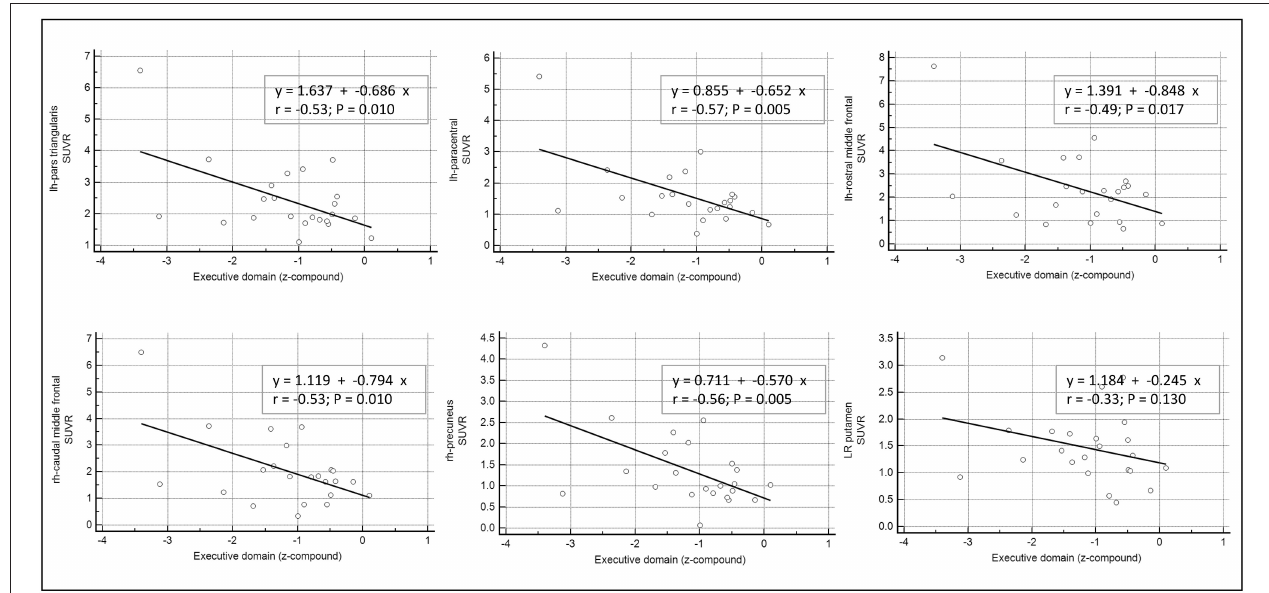
FIGURE 2 | Correlation between β -amyloid load in cortical and subcortical areas and cognitive performance. Univariate linear regression model between the executive domain ( z -compound) and the mean standardized uptake value ratios (SUVR) of each significant cortical and subcortical ROIs.